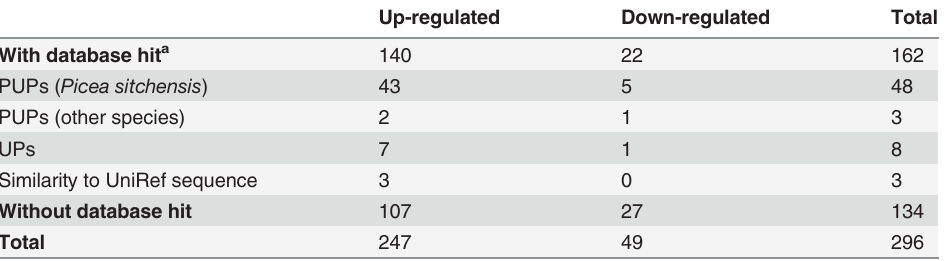
Total 247 49 296 PUP: Putative uncharacterized protein; UP: Uncharacterized protein. a ‘ Database hit ’ refers to transcripts with database accession number or similarity to a UniProt Reference Cluster (UniRef)